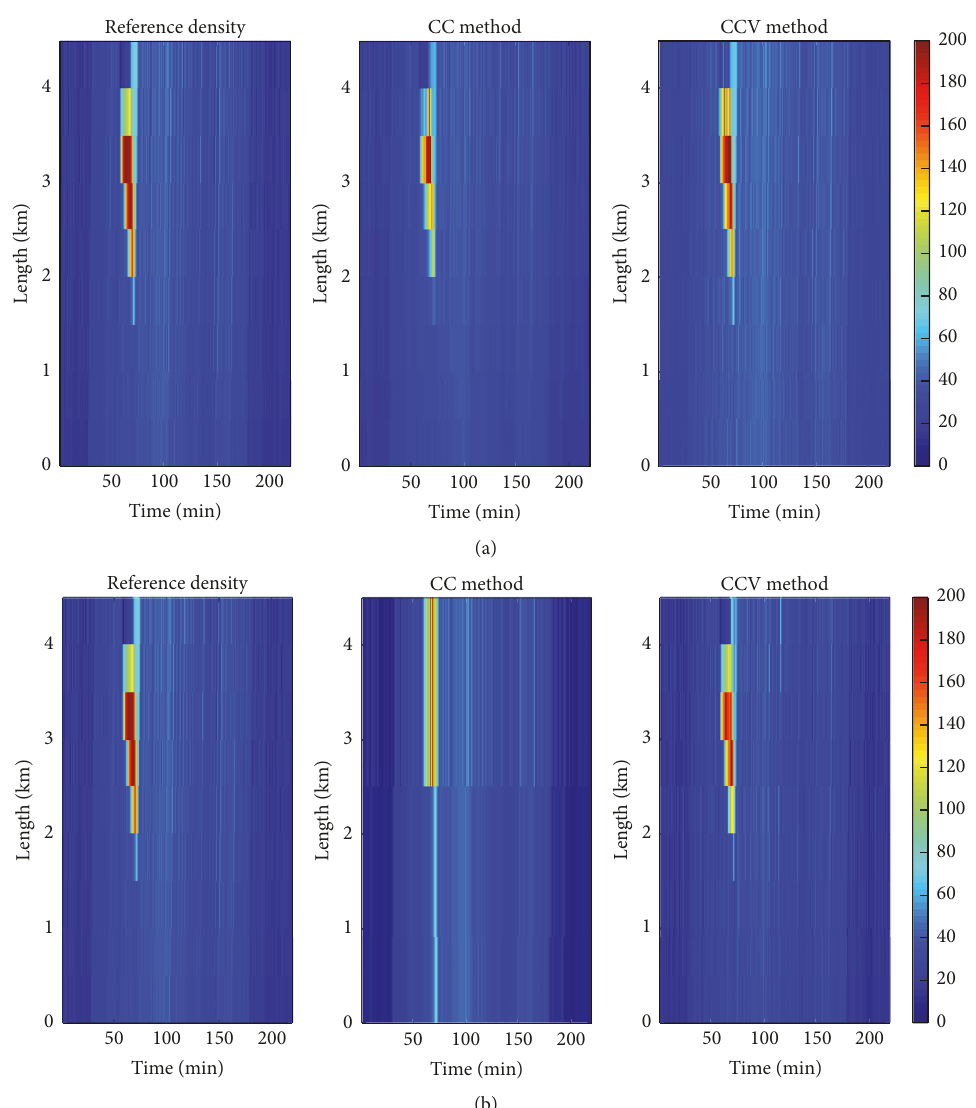
Figure 7: Reference density and density estimates using CC and CCV in time (min) and space (km) for a simulated incident scenario. The aggregation time period is 60 sec and the detector interval is 500 meters and 2500 meters in (a) and (b), respectively. The color map shows density